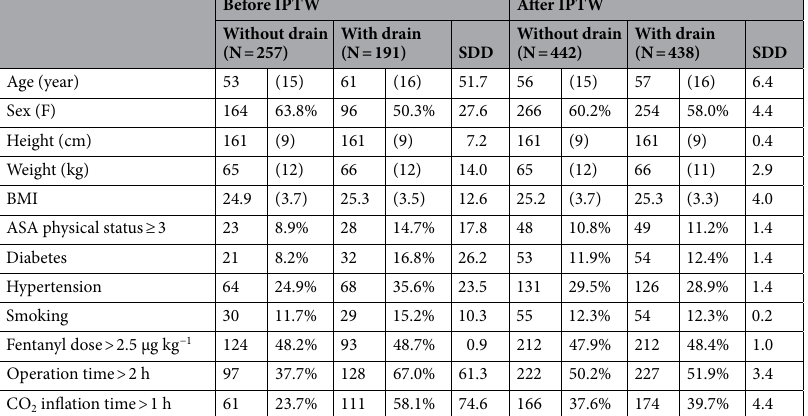
Before IPTW Without drain With drain Without drain With drain PLSP (N = 257) (N = 191) (N = 442) (N = 438) Incidence